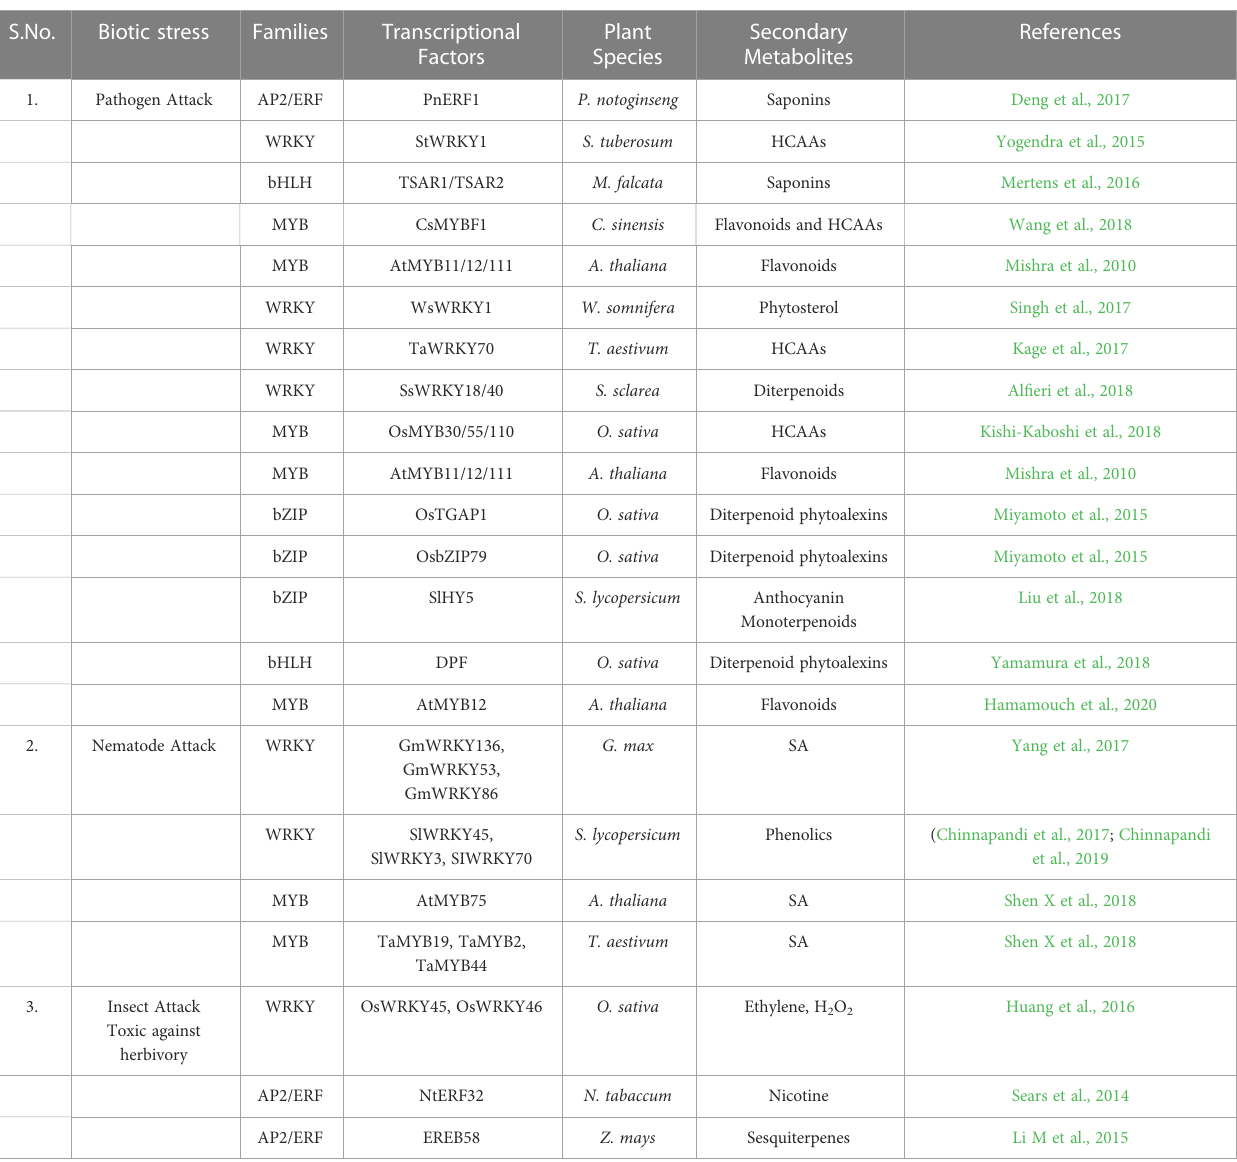
TABLE 2 Role of Transcription factors in the biosynthesis of plant secondary metabolites in plants.